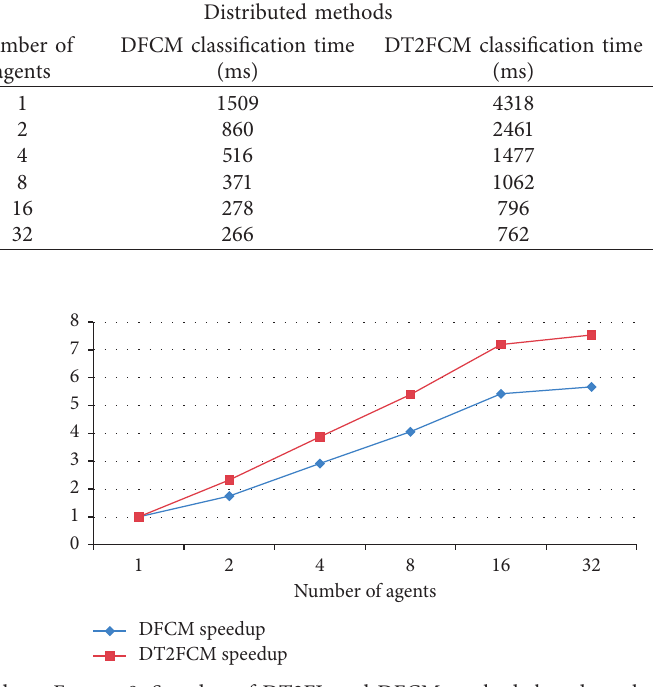
Figure 9: Speedup of DT2FL and DFCM methods based on the number of AVPE agents in the model.